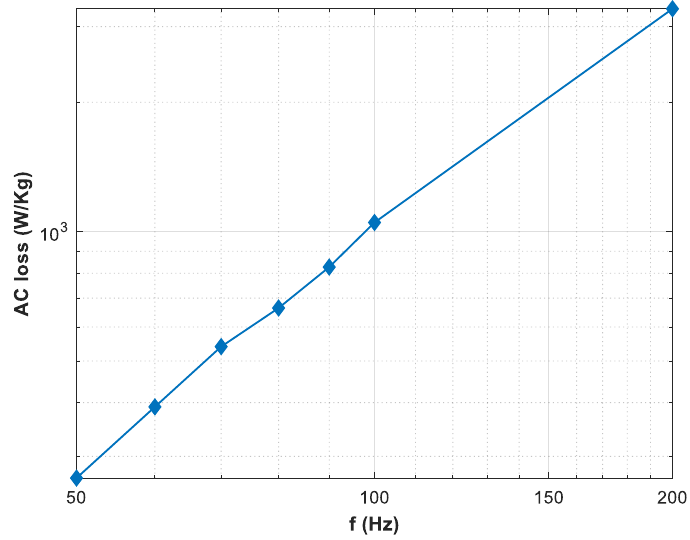
Figure 8. AC loss measured under rotating magnetic fields with multiple frequencies at 20 mT.